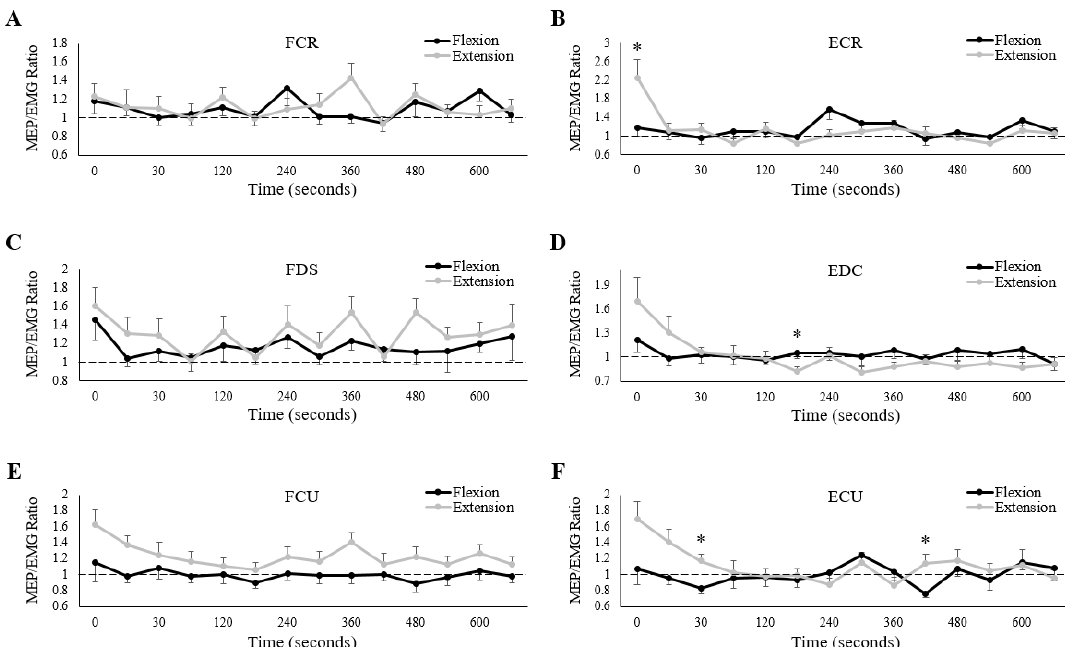
Figure 8. Group averages of MEP/EMG (both values normalized to baseline) ratios for (A) FCR, (B) ECR, (C) FDS, (D) EDC, (E) FCU and (F) ECU. Black/grey lines are muscle activity collected on the wrist flexion/extension fatigue sessions, respectively. Horizontal dashed lines represent baseline (pre-fatigue) values. The x -axes denote time, with “0” representing the first measurement immediately after the cessation of the fatigue-inducing trial. All unlabeled points occurred 15 s after the preceding time point. * denotes a significant difference between sessions at a single measurement point. Error bars represent standard error.